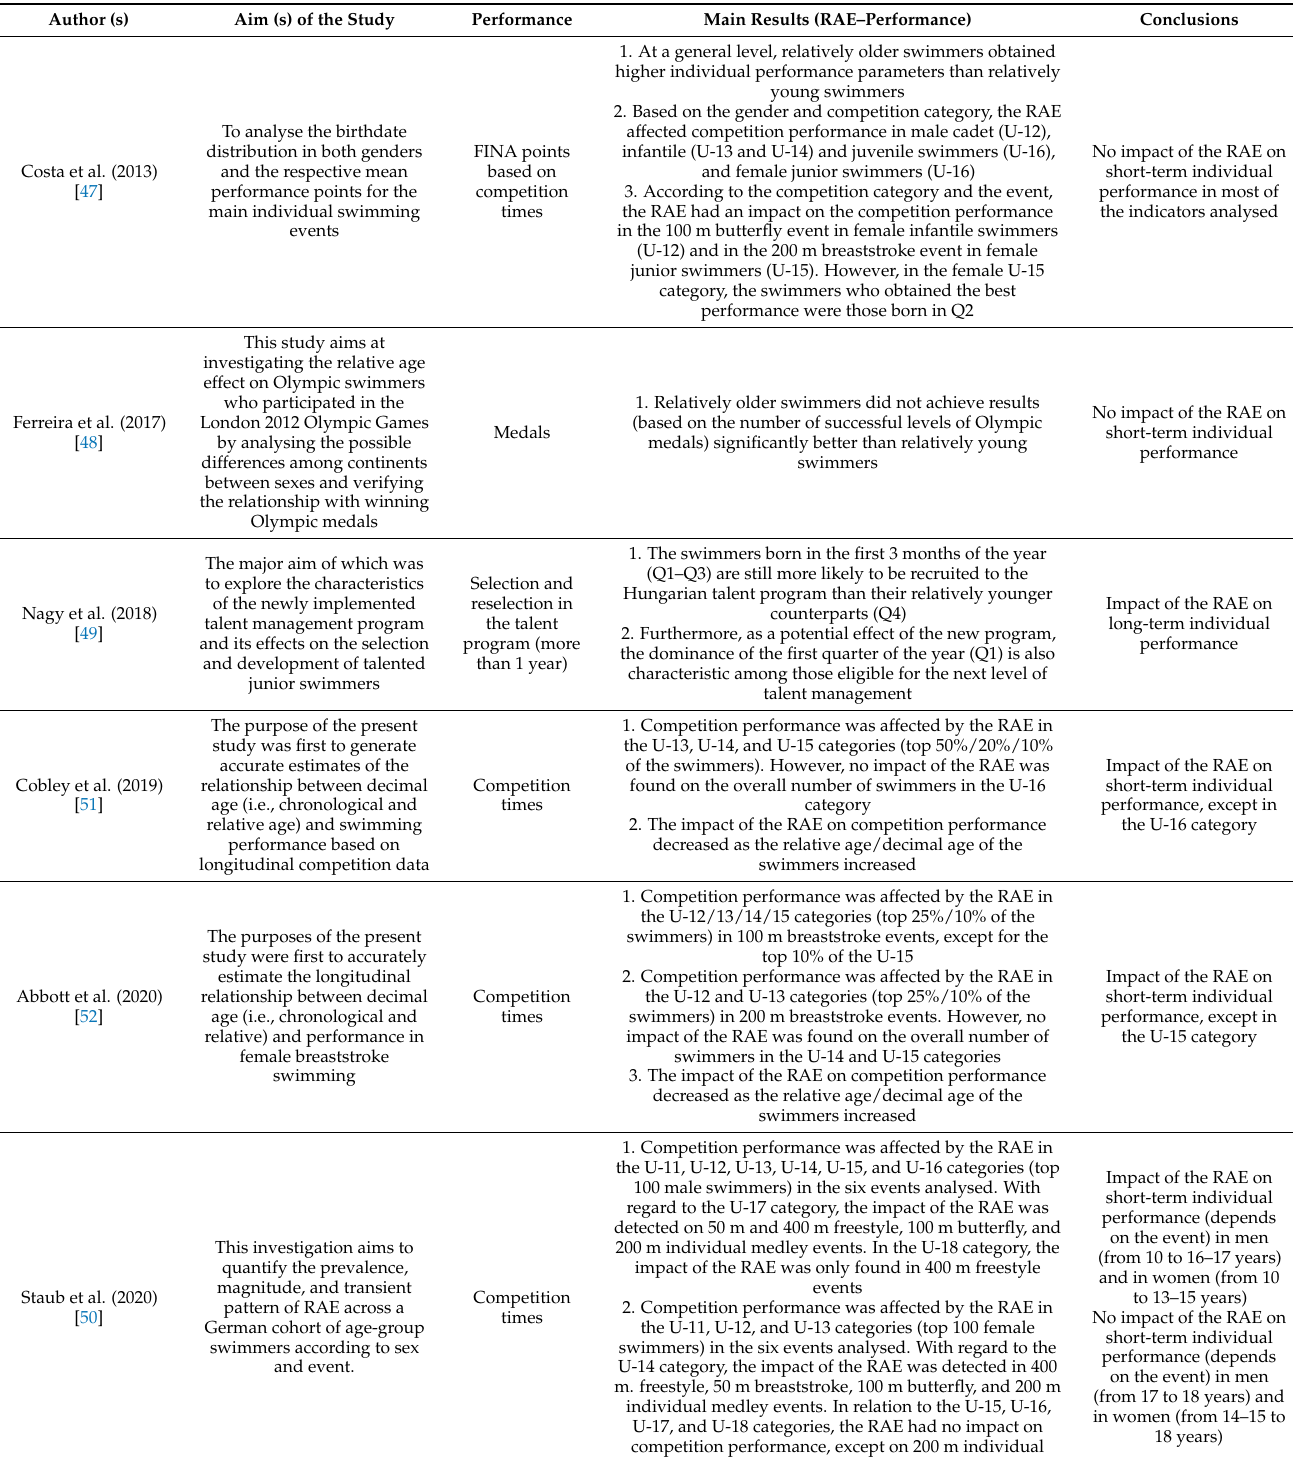
Table 2. Relationship between the relative age effect (RAE) and competition performance providing the aim(s) of the study, performance indicators, main results, and